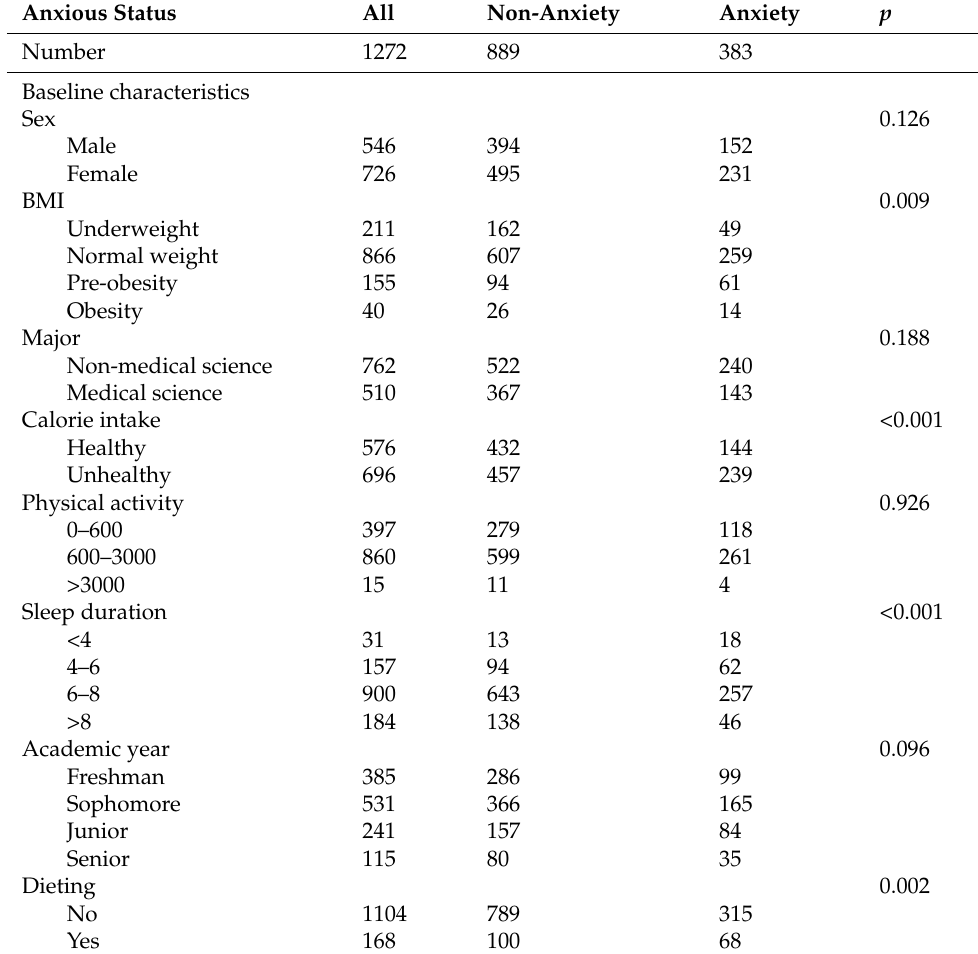
Table 3. Baseline characteristics of 1272 students stratified by anxiety and